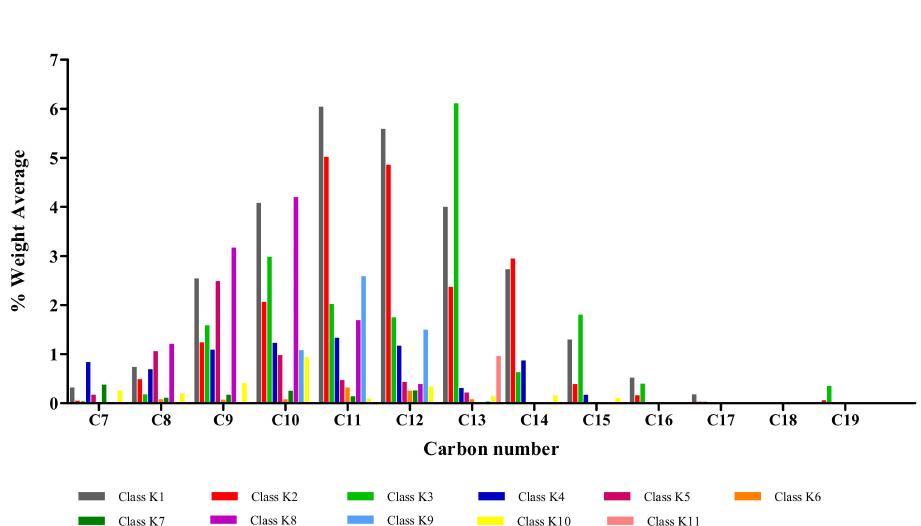
Figure 1. Fuel composition by hydrocarbon classes and carbon